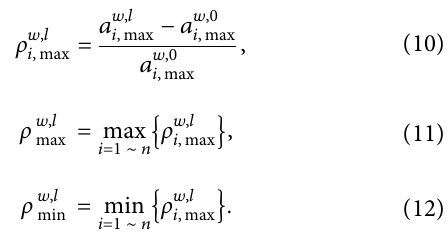
Figure 11: Te c w,l